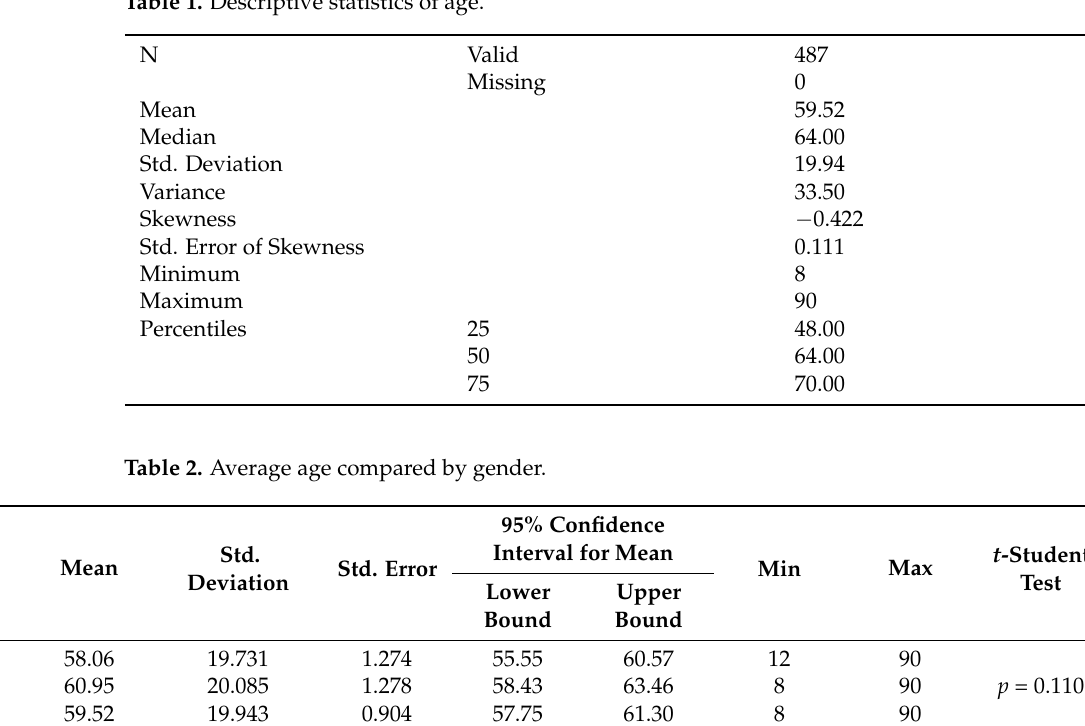
Table 1. Descriptive statistics of age.